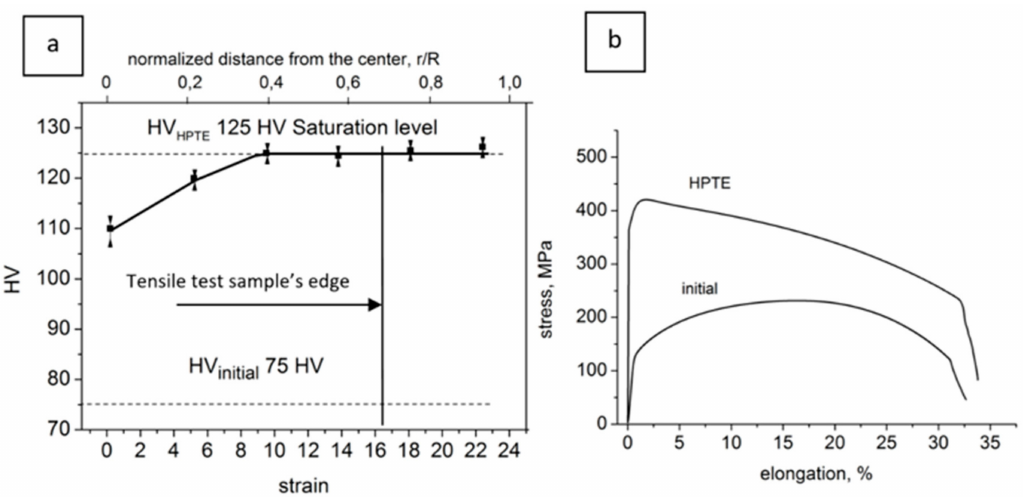
Figure 8. ( a ) Microhardness distribution along the radius and ( b ) tensile curves of Cu before and after